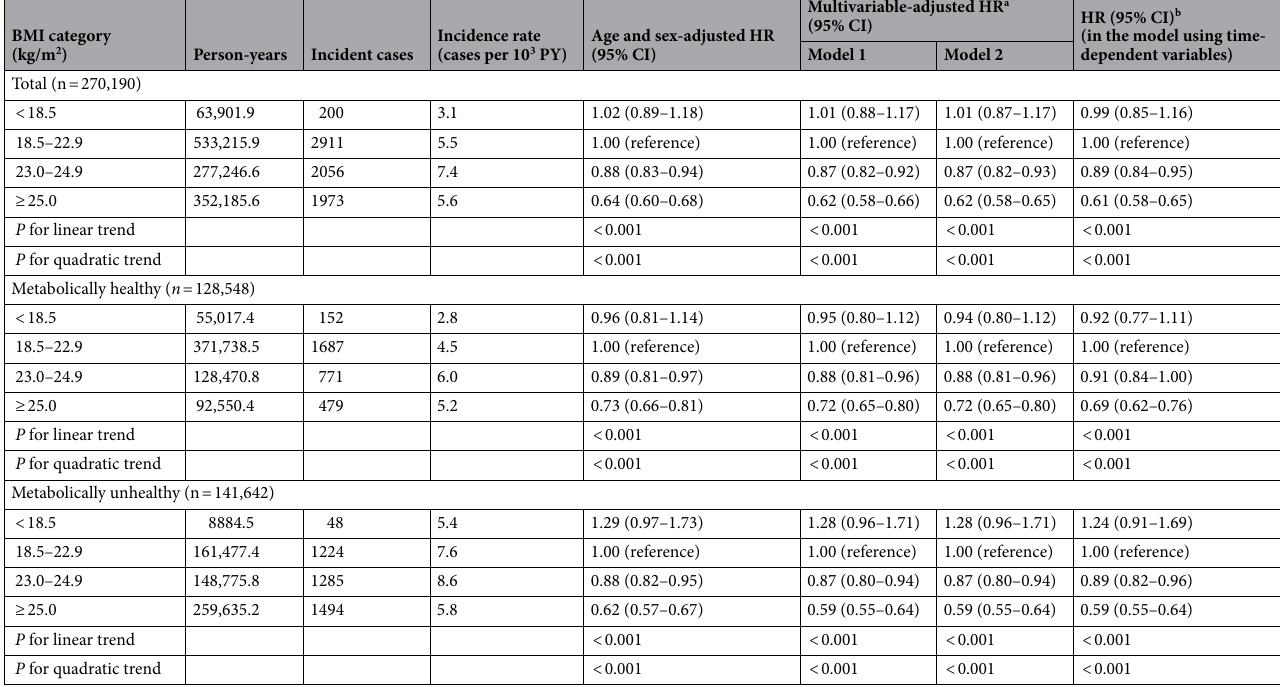
Table 3. Development of obstructive lung diseases by body mass index category in metabolically healthy and unhealthy phenotypes. P = 0.001 for the overall interaction between metabolic health status and BMI category for incident obstructive lung diseases (adjusted model 1). a Estimated from parametric proportional hazard models. Multivariable model 1 was adjusted for age, sex, centre, year of screening examination, education level, smoking status, alcohol intake, physical activity level, and total energy intake; model 2: model 1 plus adjustment for eosinophil count and high-sensitivity C-reactive protein level. b Estimated from parametric proportional hazard models with BMI category, smoking status, alcohol intake, physical activity level, and total energy intake as time-dependent categorical variables and baseline age, sex, centre, year of